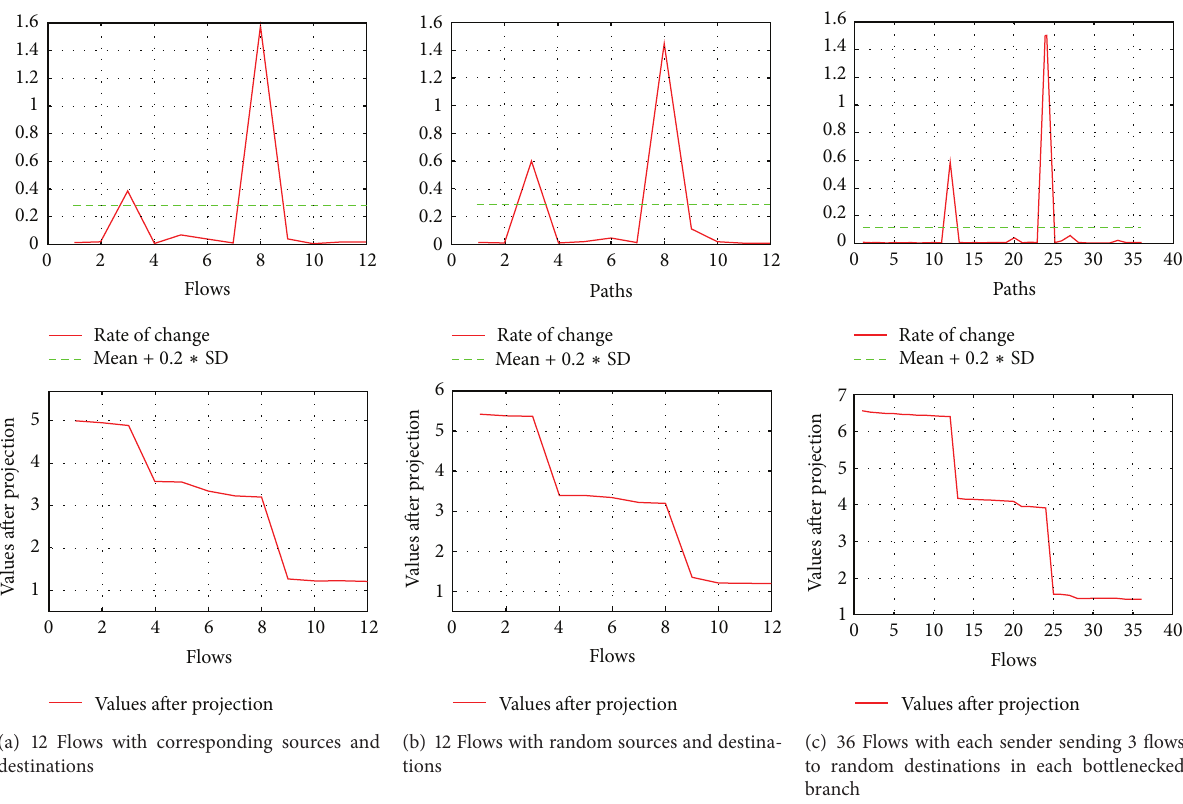
Figure 8: Results of experiments without common endpoints.